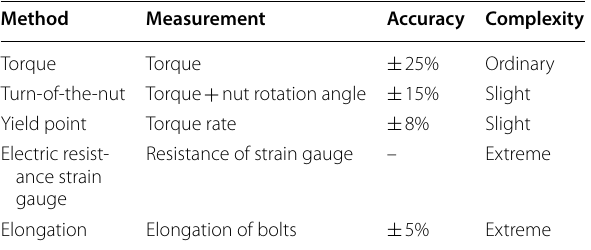
Table 1 Comparison of